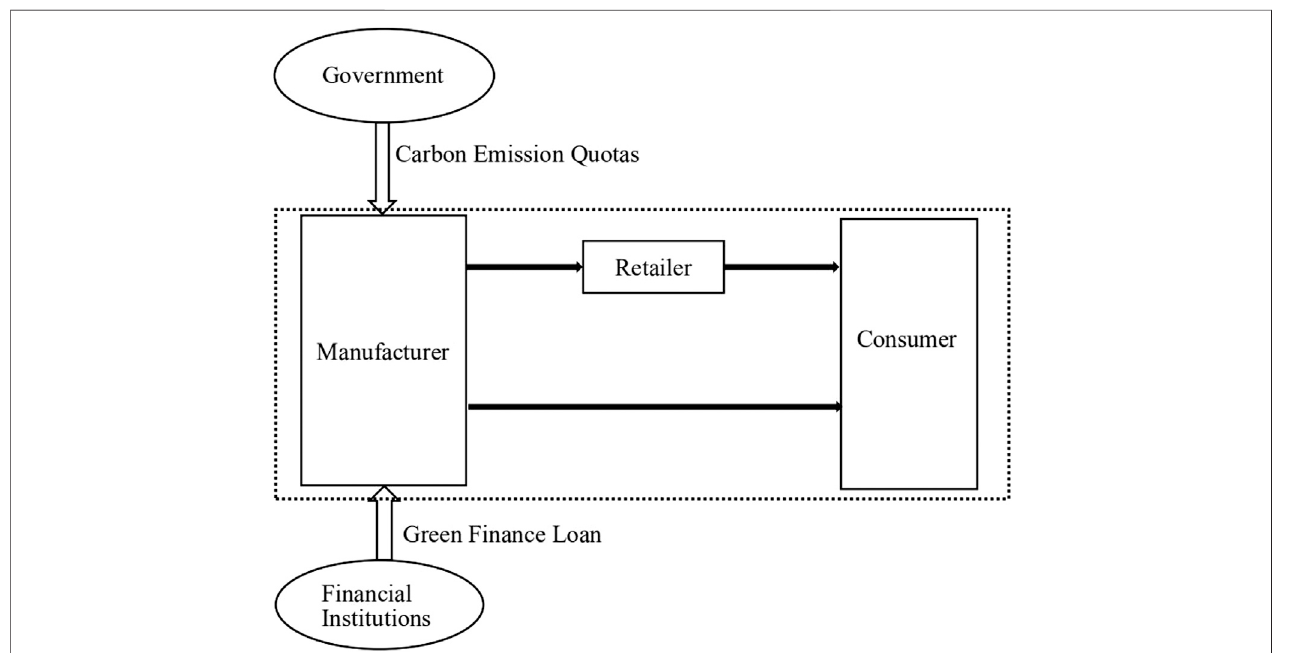
FIGURE 1 | Dual-Channel supply chain